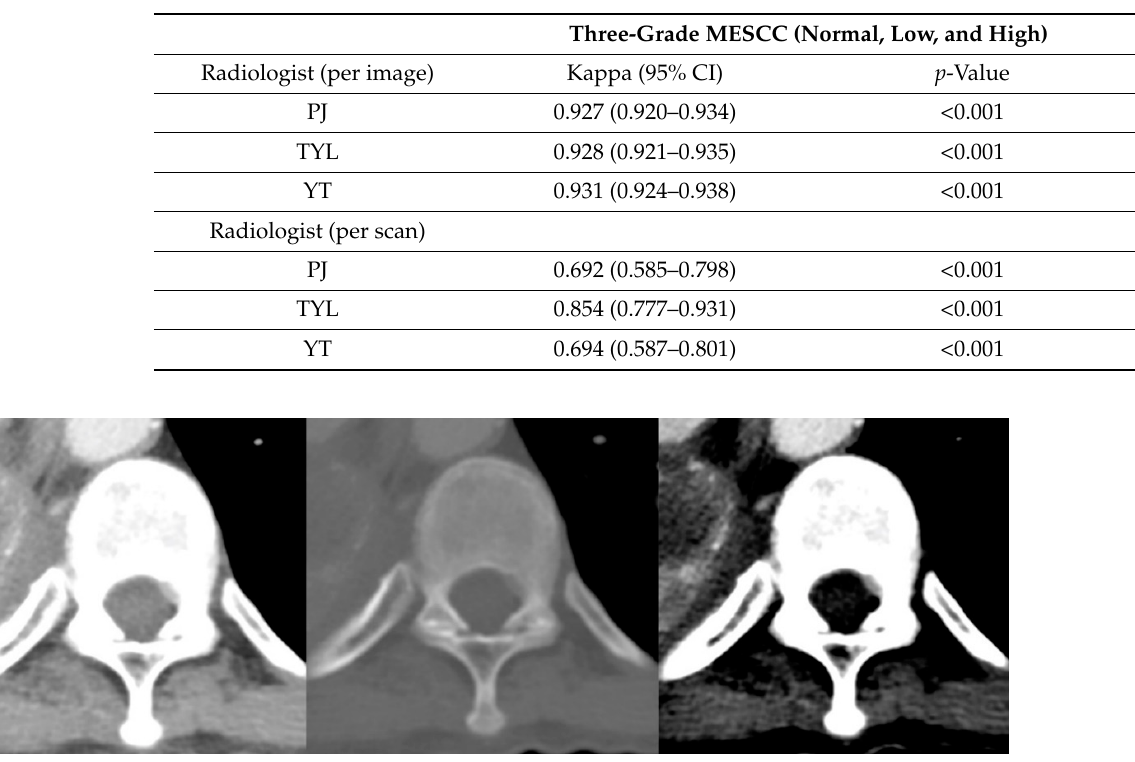
Figure 4. Axial CT image of the cervicothoracic junction overcalled as low-grade epidural disease by two radiologists. No epidural disease was present on the corresponding MRI (not shown). As- sessment is complex due to overlap and angulation of the lower cervical and upper thoracic spine in the axial plane with background degenerative changes. 3.4. Two-Grade (Normal/Low Versus High-Grade) MESCC Classification All radiologists showed almost perfect agreement for two-grade normal/low versus high-grade MESCC per CT image with kappa values ranging from 0.967 (PJ, 95% CI 0.962– 0.972) to 0.978 (TYL, 95% CI 0.974–0.982) (Table 6).